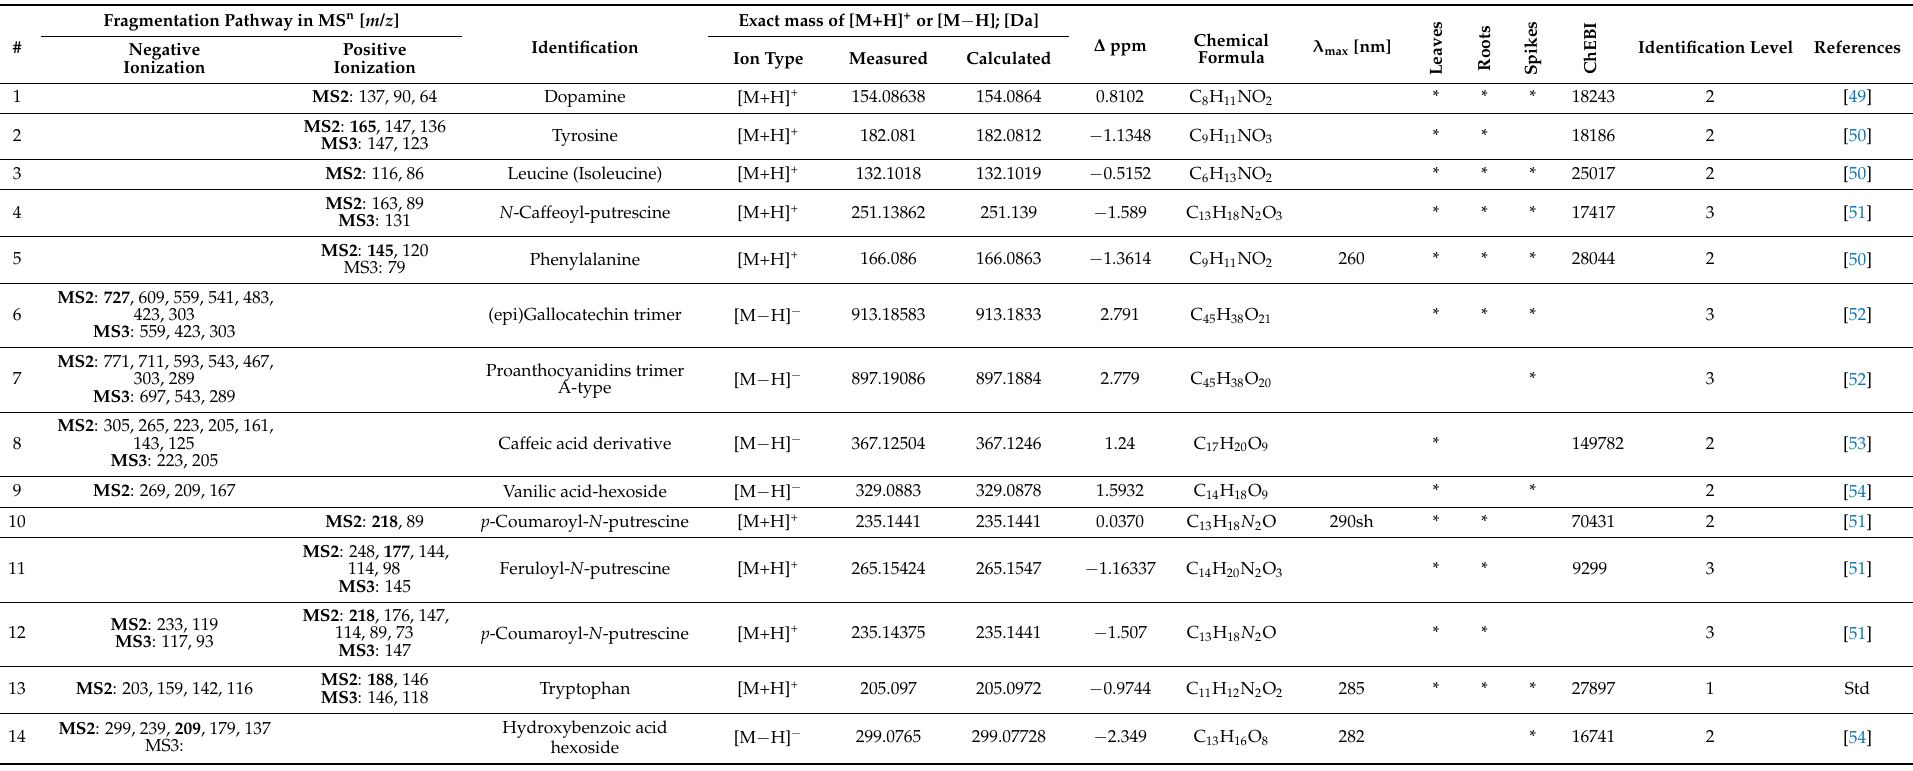
Table 3. Specialized metabolites identified in leaves, roots and spikes of Brachypodium, using two complementary MS systems: HPLC-ESI-MS n and UPLC-HR- MS/MS. Chemical formulas were calculated on the basis of accurate masses measured in HR-MS/MS, and fragmentation pathways are given on the basis of ESI-MS n . The main peaks in MS2 or MS3 taken for further fragmentation are highlighted in bold. Identification levels are given according to the Metabolomics Standards Initiative recommendation [47]. ChEBI—respective identifiers of chemical structure in the Chemical Entities of Biological Interest database [48]. *—indicates detection of metabolites in particular organs. #—ChEBI identifiers for other optic isomers of the compound: 75667, 75666, 75668, 75672, 75670, 75669. Std.—identification supported with analysis of available standard compounds; sh—spectrum